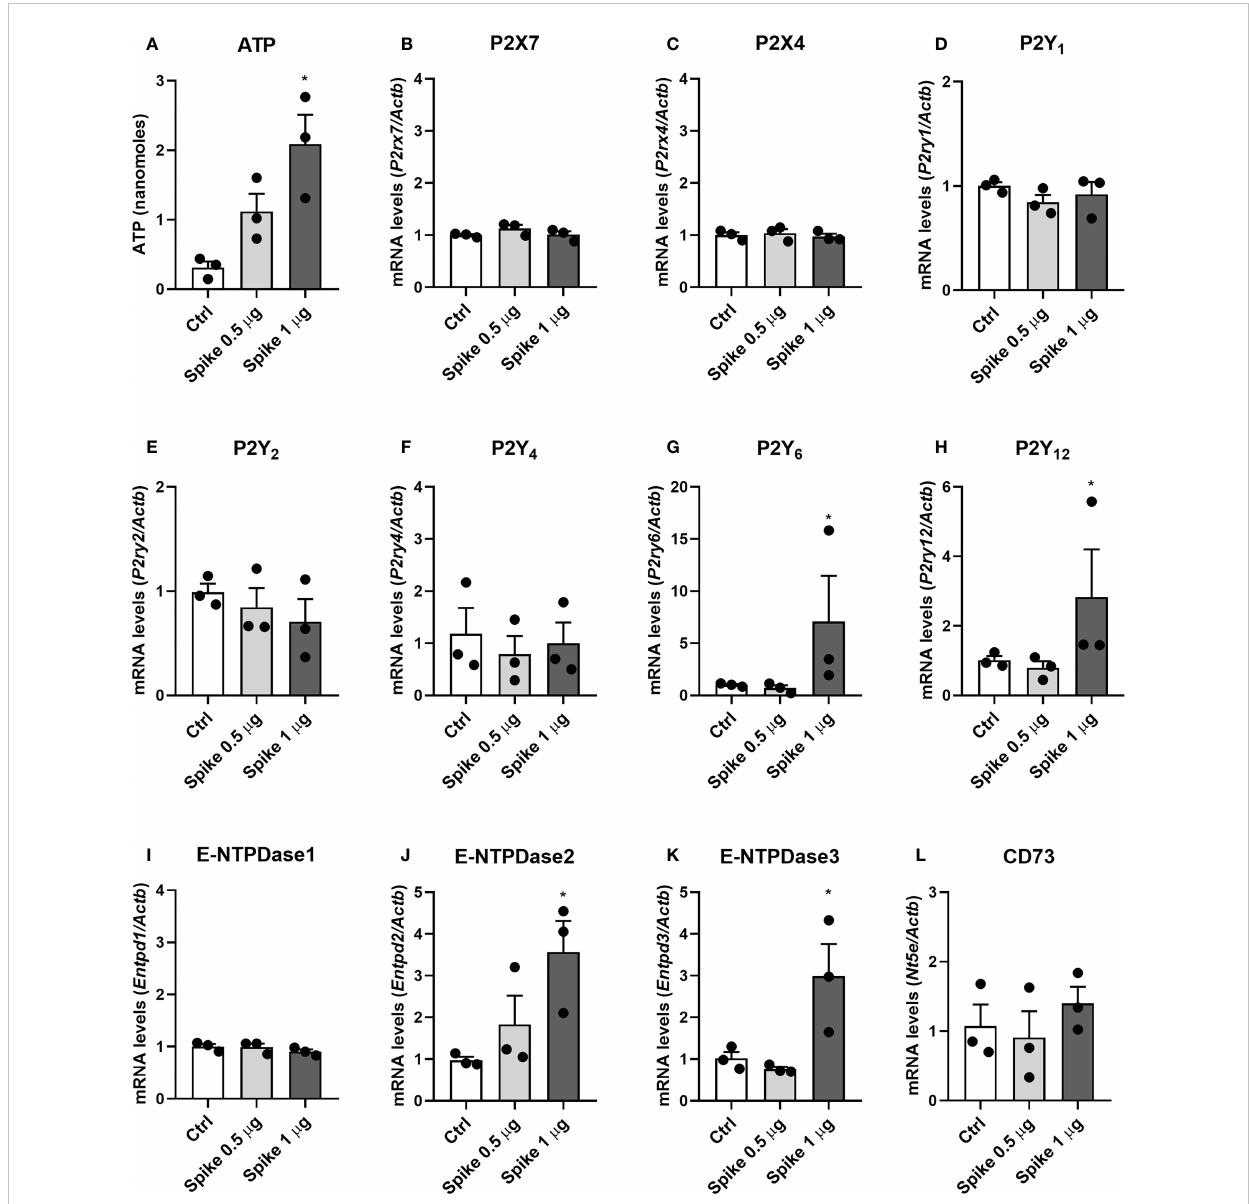
FIGURE 1 SARS − CoV − 2 spike protein increases ATP secretion and purinergic signaling components transcript levels in microglial cells. BV-2 cells were left untreated (Ctrl) or stimulated with 0.5 or 1 µg/mL SARS − CoV − 2 spike protein for 2h for ATP quanti fi cation in culture supernatants or 24 h for qPCRs. (A) ATP concentration in cell supernatants. The levels of transcripts for (B) P2X7, (C) P2X4, (D) P2Y 1 , (E) P2Y 2 , (F) P2Y 4 , (G) P2Y 6 , (H) P2Y 12 , (I) E- NTPDase1, (J) E-NTPDase2, (K) E-NTPDase3, and (L) CD73 were analyzed by RT-qPCR. Data are representative of three independent experiments (n=3) performed in triplicates and expressed as mean ± SEM. Statistically signi fi cant differences between Ctrl and treated groups are represented by asterisks (*, p < 0.05). One-way analysis of variance, Tukey ’ s